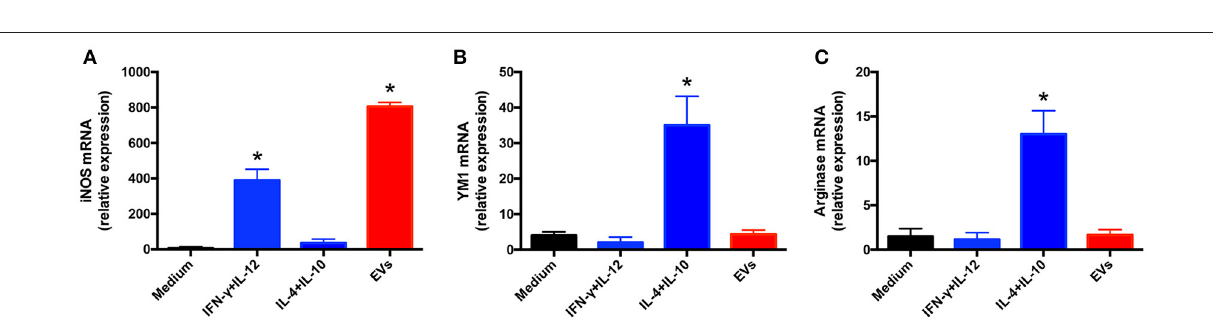
FIGURE 4 | Extracellular vesicles (EVs) from T. interdigitale promote classical macrophage activation. Bone marrow-derived macrophages (BMDMs) from C57BL/6 mice were incubated at 37 ◦ C for 6h with EVs (10 7 particles/mL and with either IFN- γ (2ng/mL) plus IL-12p40 (50ng/mL) as M1 inducers (classical activation) or IL-10 plus IL-4 (both at 50ng/mL) as M2 inducers (alternative activation). The medium was used as the negative control. RNA was extracted and converted into cDNA and real-time PCR was used to evaluate the relative expression of iNOS ( A ), Ym-1 ( B ), and arginase-1 ( C ). Data are representative of 3 experiments. The results are expressed as means ± SEM and are compared to the results obtained for the negative control. * P <